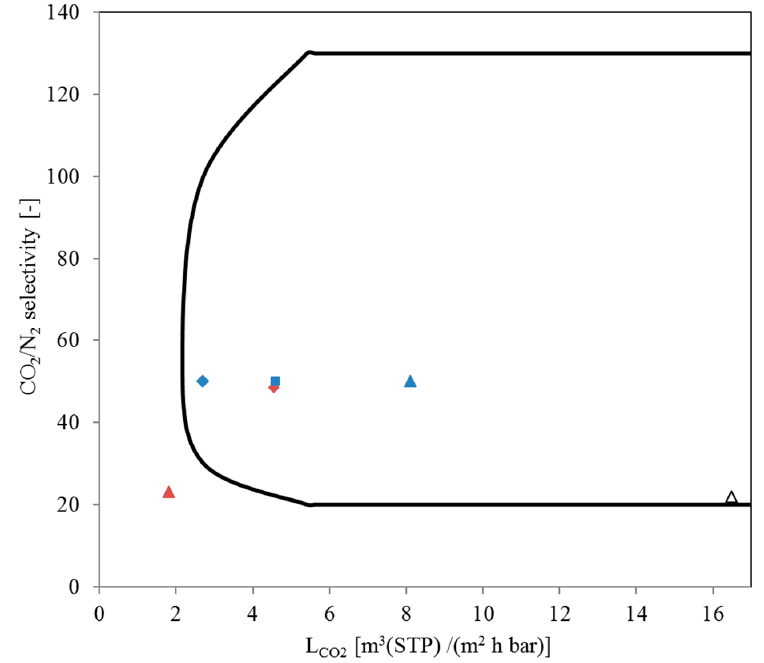
Figure 17. CO 2 /N 2 selectivity vs. CO 2 permeance trade-off plot [44]/Comparison of IL membranes with polymeric membranes: ♦ Polaris™ Gen-1 (commercial scale) [11]; ■ Polaris™ Gen-2 (pilot scale) [11]; (cid:78) Polaris™ advanced (lab scale) [11]; (cid:7) PolyActive™ 1500 [9]; (cid:78) SILM with EMIM Tf2N ∆ TFCM with EMIM Tf2N